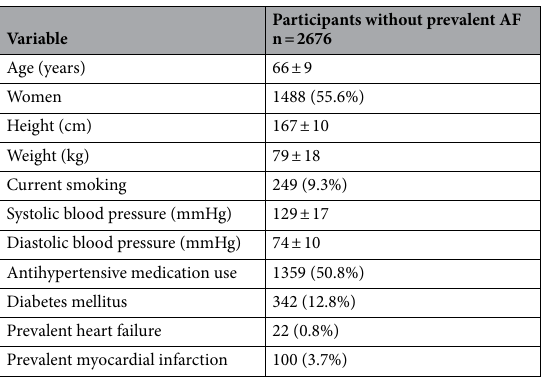
Table 1. Baseline characteristics of study sample. Values are represented as n (%) for dichotomous variables or mean ± standard deviation (SD) for continuous